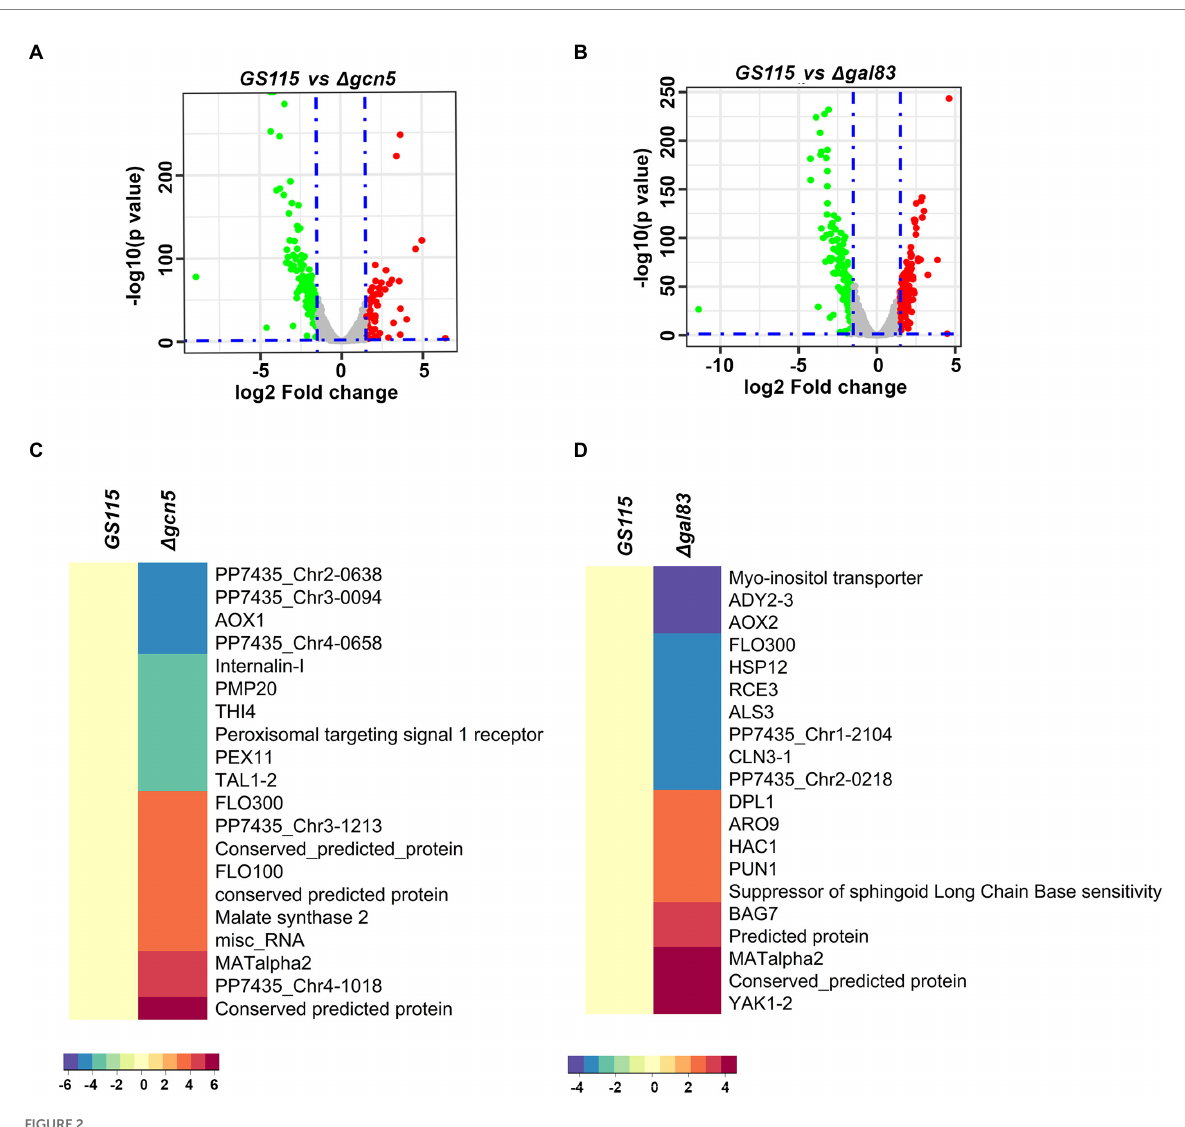
FIGURE 2 RNA-Seq analysis of Δ gcn5 and Δ gal83 cultured in YNBM. (A,B) Volcano plots of Δ gcn5 and Δ gal83 cultured in YNBM depict the overall changes in transcription profile. (C) Heat Map of the most highly downregulated and upregulated genes in Δ gcn5 relative to GS115 . (D) Heat map of the most highly downregulated and upregulated genes in Δ gal83 relative to GS115